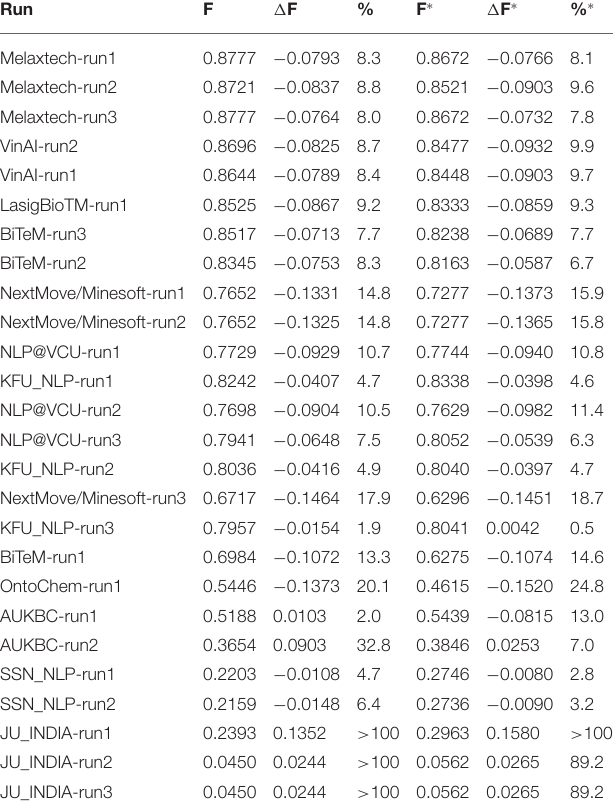
TABLE 12 | Evaluation results on T new .